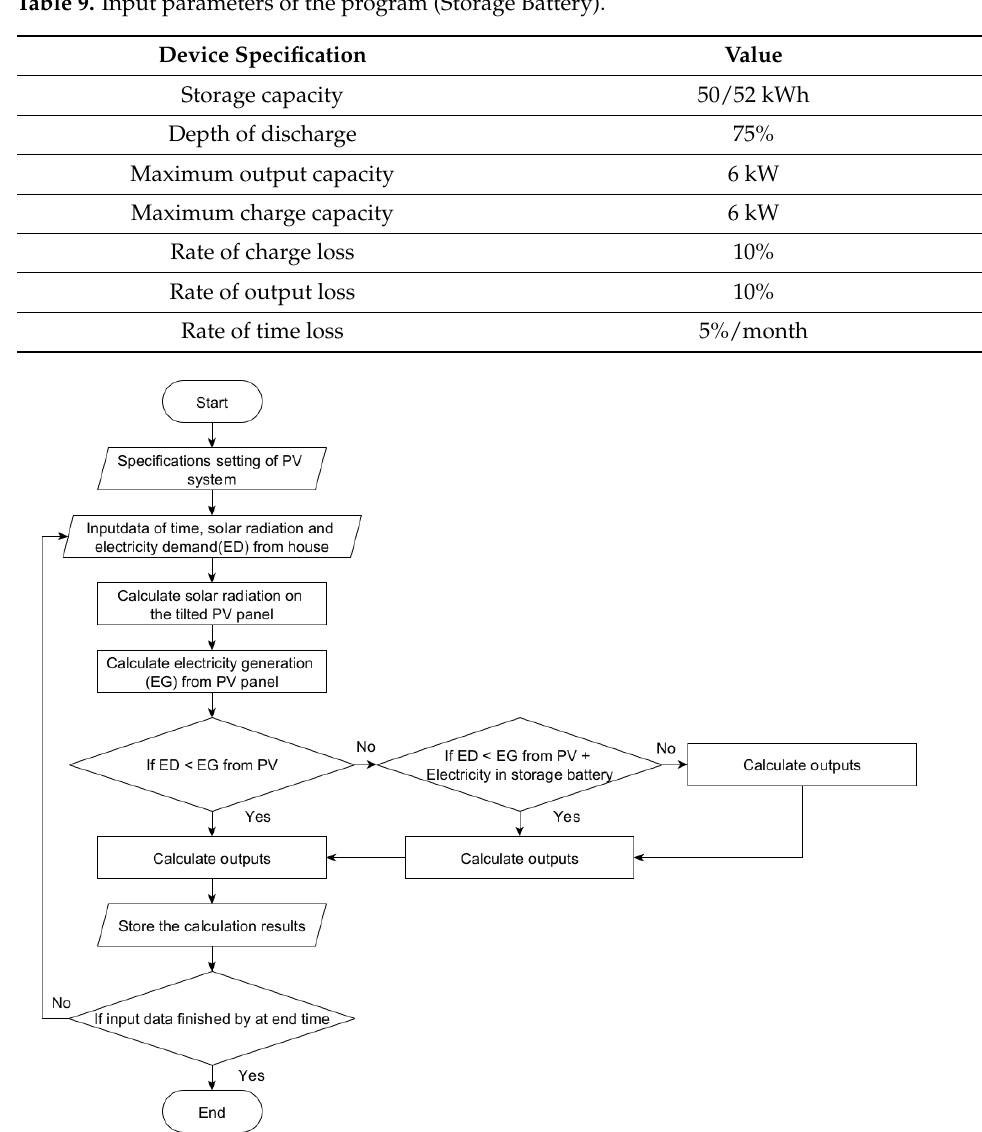
Figure 15. Program flowchart of PV and storage battery system.